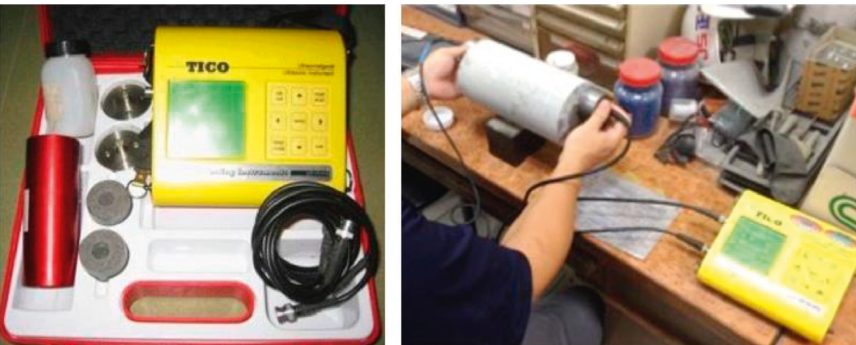
Figure 4: Ultrasonic pulse velocity test and TICO ultrasonic pulse velocity.